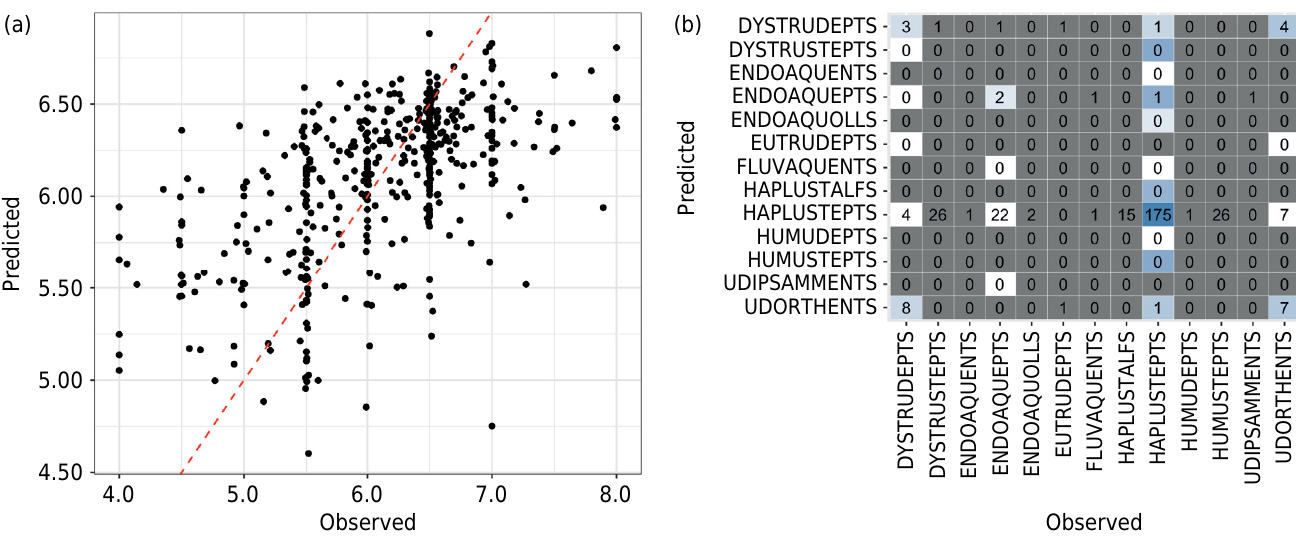
Figure 4. Scatter plot (a) and confusion matrix (b) charts comparing predictions vs observations in the test set according to the best model for predicting pH 0.00-0.30 m and great groups, respectively.